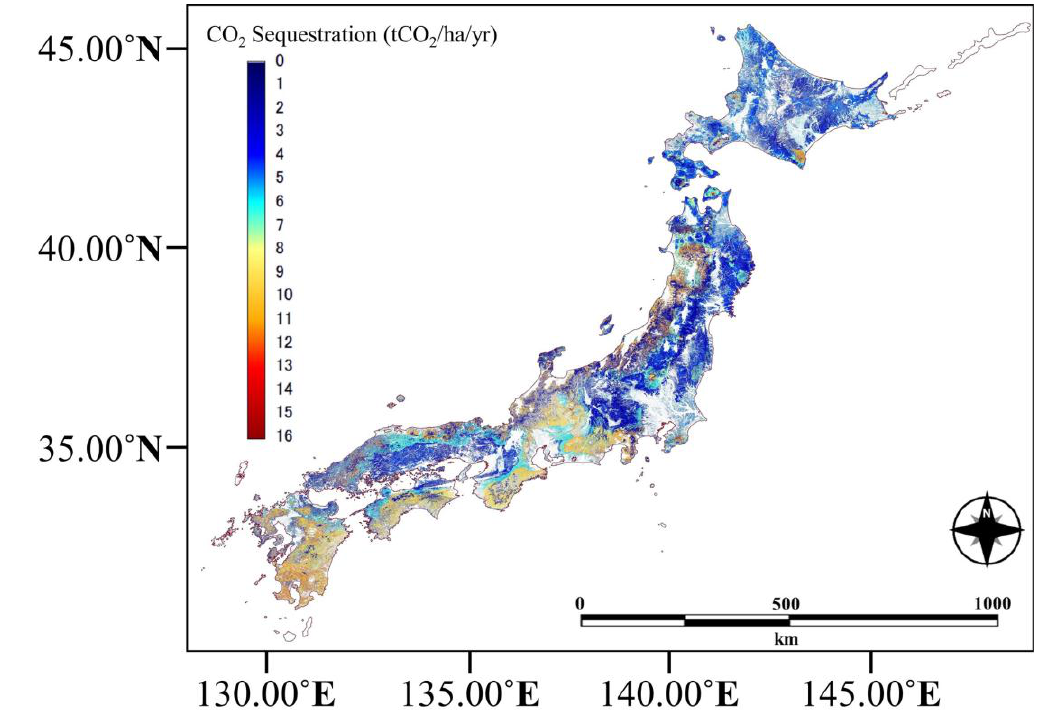
Figure 14. CO 2 sequestration map of